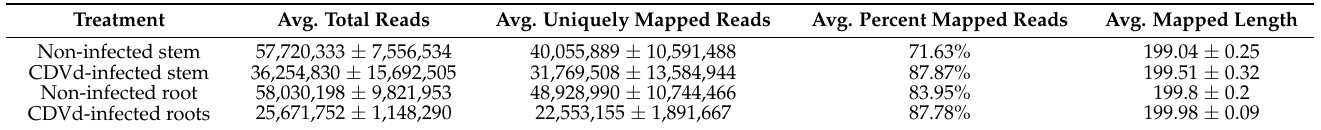
Table 1. Summary of sequencing and STAR alignment results for non-infected and citrus dwarfing viroid (CDVd)-infected trees from the stem ( Citrus sinensis (L.) Osbeck) and root tissues ( C. trifoliata (L.).